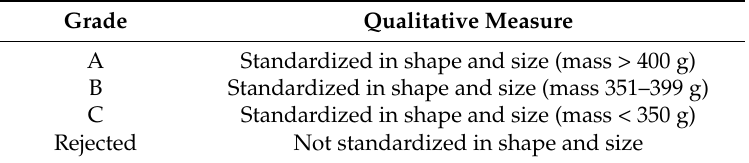
Table 1. Market grading standards for Harumanis mango set by the Perlis Department of